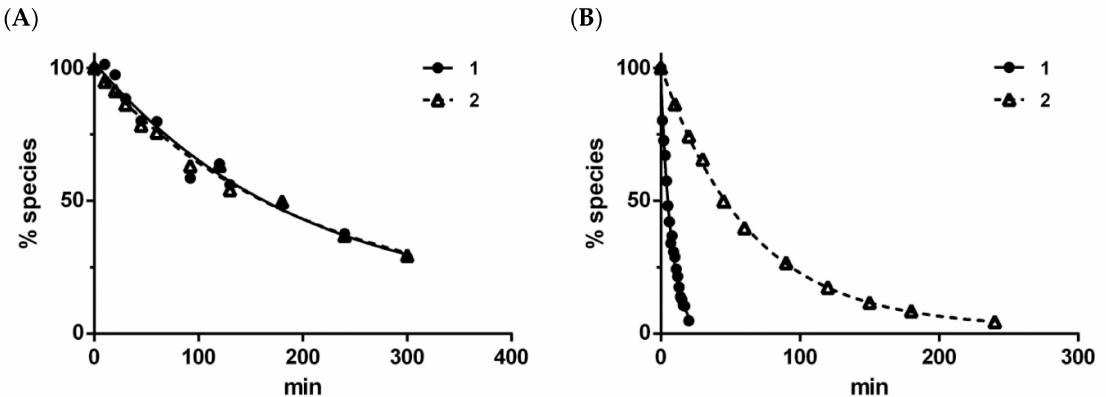
Figure 2. Time courses ( mean, n = 2 ) for chlorambucil derivatives 1 and 2 during chemical conversion in phosphate buffer ( pH 7 . 4 ) ( A ) and enzymatic conversion in human microsomes ( pH 7 . 4 ) ( B ) at 37 °C .